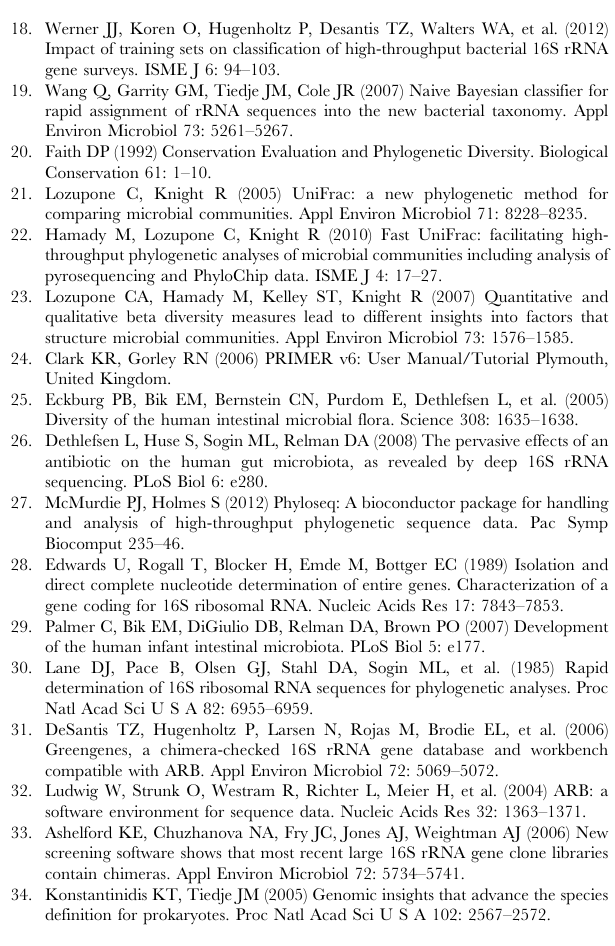
Figure S9 Relative abundance of dominant genera in Bacteroidetes. (A) Bacteroides is the major genus enriched in the gut communities of U.S. children. The monthly temporal changes in relative abundance of Bacteroides are illustrated for all of the U.S. children. (B) In contrast, Prevotella is the dominant genus within Bacteroidetes in Bangladeshi children. The monthly temporal changes in relative abundance of the Prevotella are illustrated for all of the Bangladeshi children (Bangladeshi child subjects, excluding BK subjects). Figure S10 Rarefaction curve of near full-length 16S rDNA sequences and weighted UniFrac distance com- parisons between near full-length versus V1–V3 se- quences. (A) The rarefaction curve for all near full-length sequences for the 15 time points from subjects Bangladeshi child 12 M, Bangladeshi child 13 M, and Bangladeshi child 13F (Table 1). The blue line represents the observed species richness. The red line represents the range of estimated OTU richness as predicted by the Chao1 non-parametric estimator and indicates that the total OTU richness is much higher than observed with our available near full-length 16S rDNA clone library sampling. The error bars on the Chao1 estimator correspond to the lower and upper bound 95% confidence intervals. (B) Weighted UniFrac PCoA was used to represent the similarity between our near full- length sequencing and V1–V3 pyrosequencing efforts. Near full- length sequences filtered to the V1–V3 region in silico were